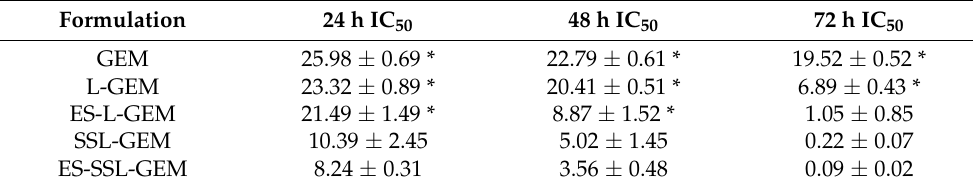
Table 2. IC 50 values (ng/mL) of different GEM formulations on A549 cells (n =